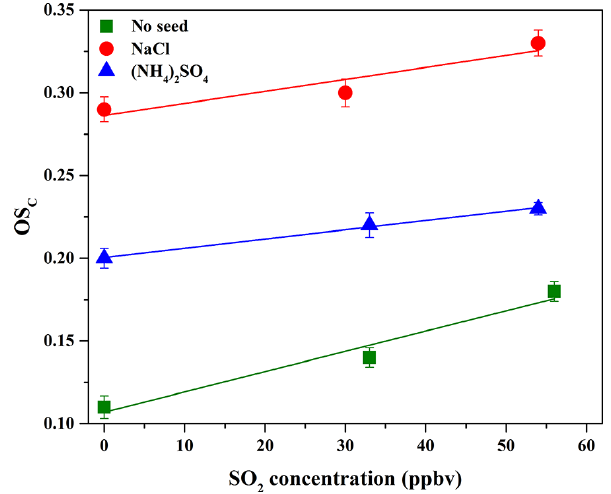
Figure 5. OS C of SOA formed in the presence of various seed par- ticles as a function of SO 2